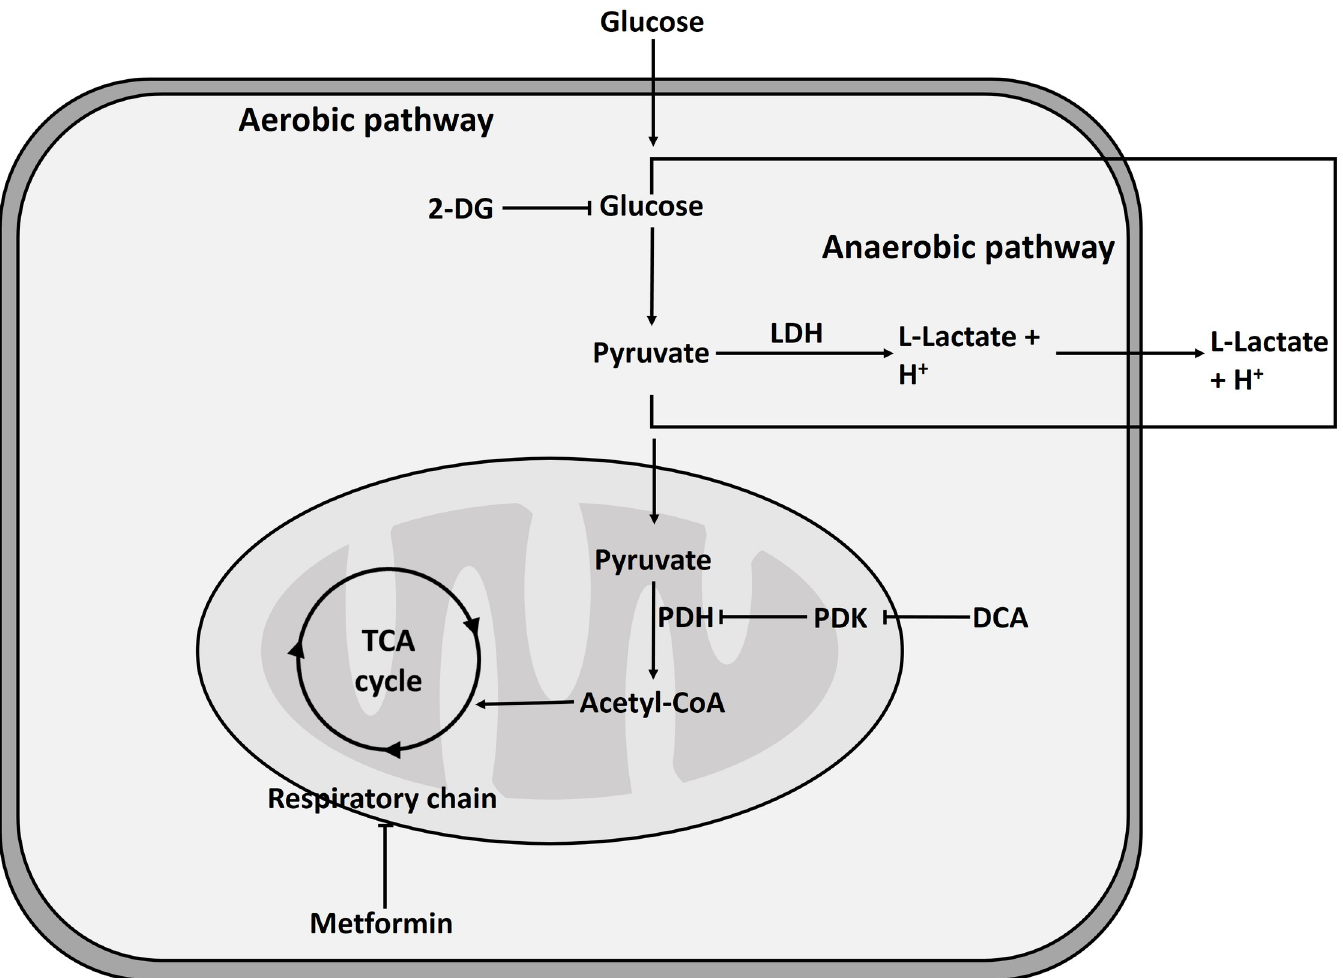
Fig 3. Regulation of aerobic and anaerobic pathway by several metabolic regulators. Schematic representation of utilized glycolysis regulators and their targets in the aerobic and anaerobic pathway. LDH = lactate dehydrogenase; PDH = pyruvate dehydrogenase; PDK = pyruvate dehydrogenase kinase; TCA cycle = tricarboxylic acid